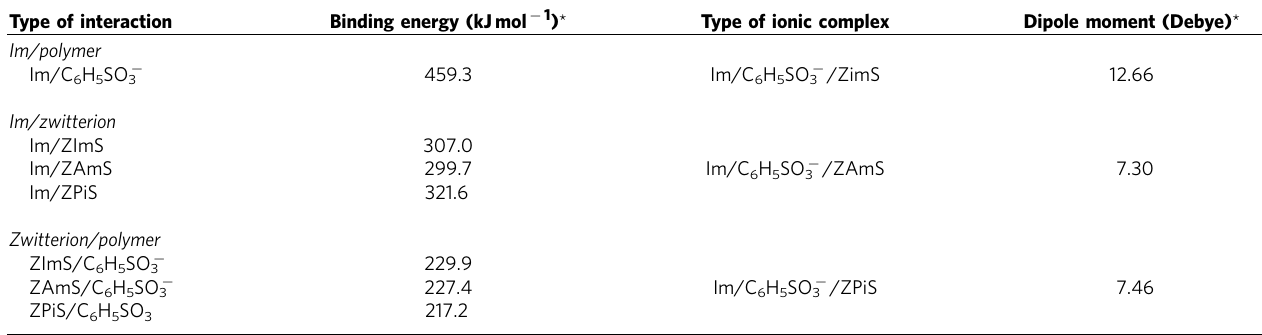
Table 1 | Ab initio interaction energies of a range of ionic interactions and dipole moments for different types of ionic complexes at 0K in a